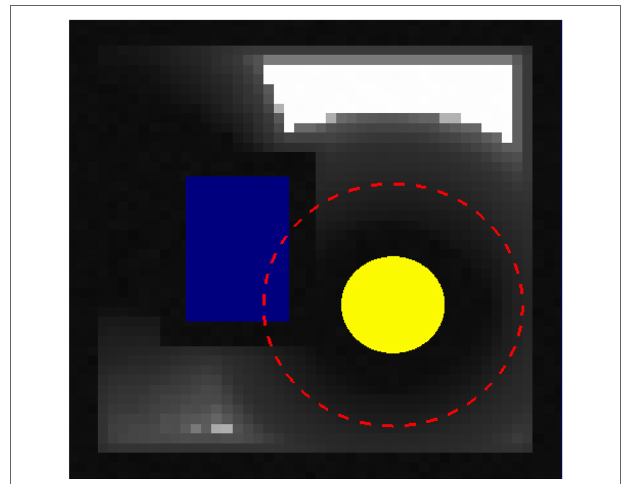
FiGUre 10 | A visualization of the human-to-robot (HtR) transfer empowerment dependent on robot position (dark—low, light—high). In this scenario, the robot will mirror the human’s movement if it has a direct line of sight. This creates a high amount of potential causal flow through the robot where the latter sees the human. It results in comparatively high transfer empowerment in those areas where the robot has both a direct line of sight to the human (yellow) and is not shut down by close proximity to the human. The highest transfer empowerment is attained at a distance, but in an area where the robot can see and react to the human; with this, the robot provides the human with operational proximity, i.e., the ability to influence the robot’s resulting